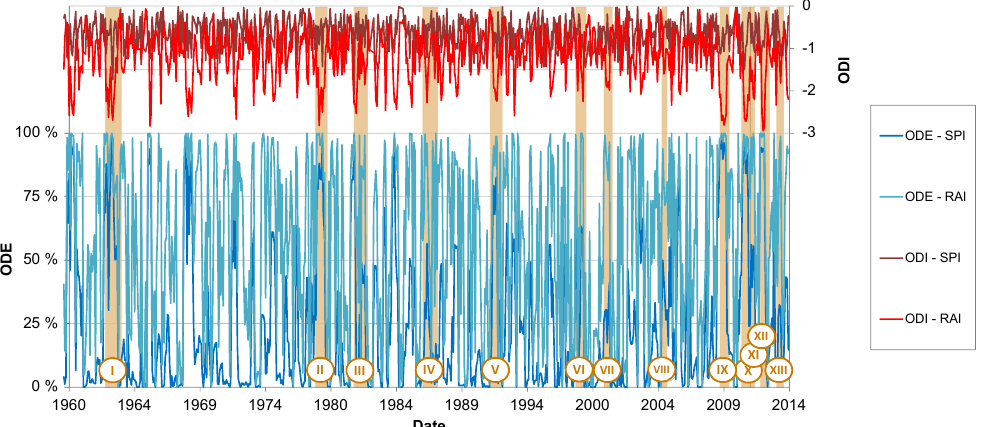
Figure A1. ODE and ODI values using the 1-month timescales of SPI and RAI indices, compared with the 13 detected historical droughts (in orange).